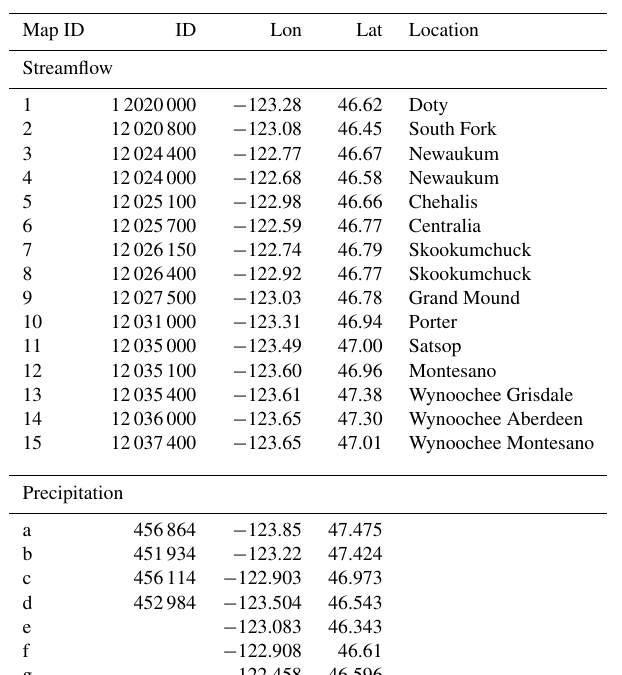
Table 1. Streamflow and precipitation observations. Map ID corre- sponds to the locations on the map of Fig.